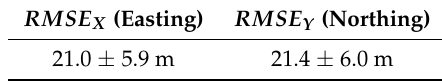
Table 9. Linear root mean square error with respect to reference